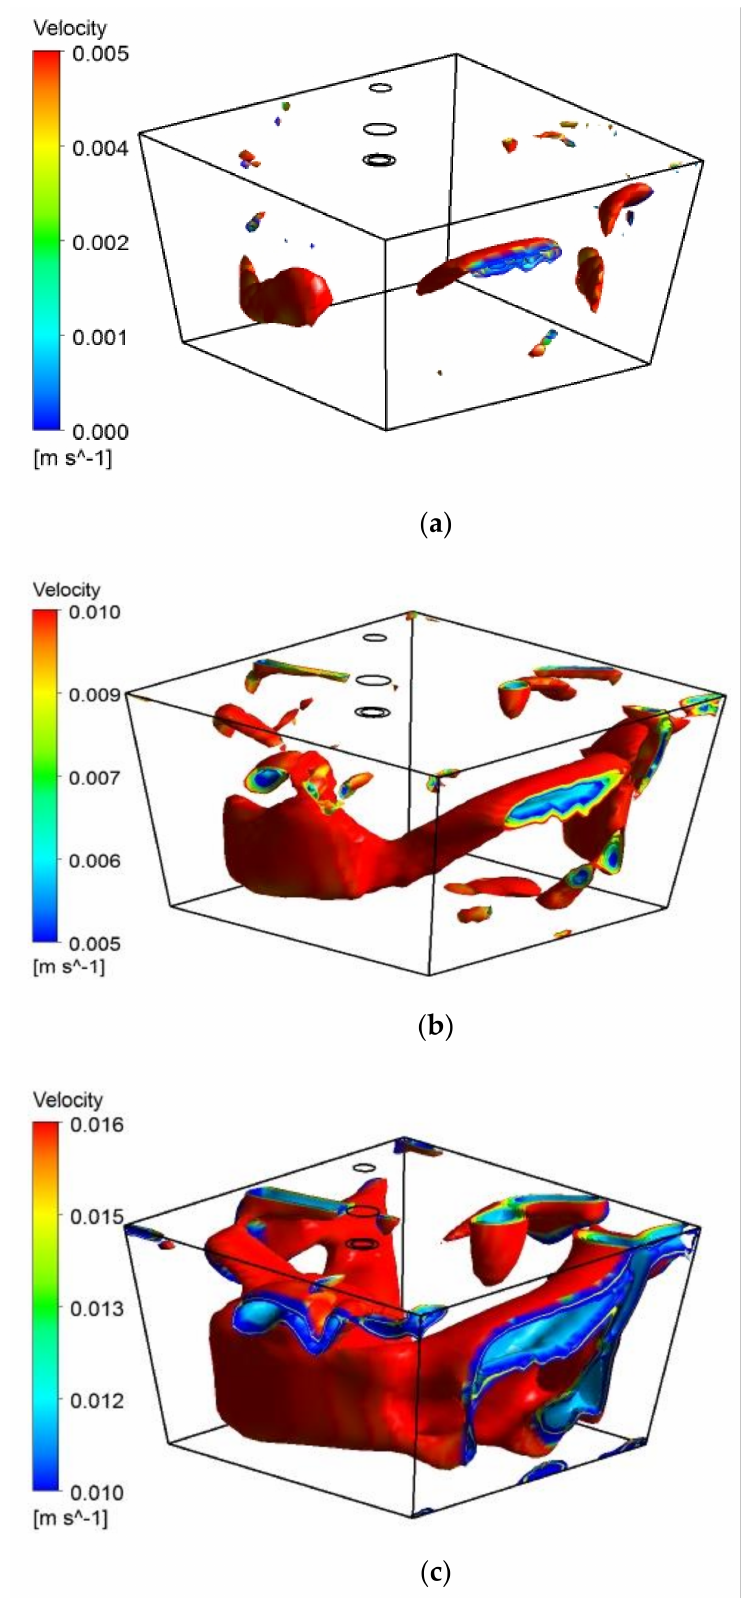
Figure 10. Three-dimensional visualization of dead region in the receiving chamber. ( a ) The isosurface of flow velocity at 0.001 to 0.005 m/s; ( b ) the isosurface of flow velocity at 0.005 to 0.010 m/s; ( c ) the isosurface of flow velocity at 0.010 to 0.016